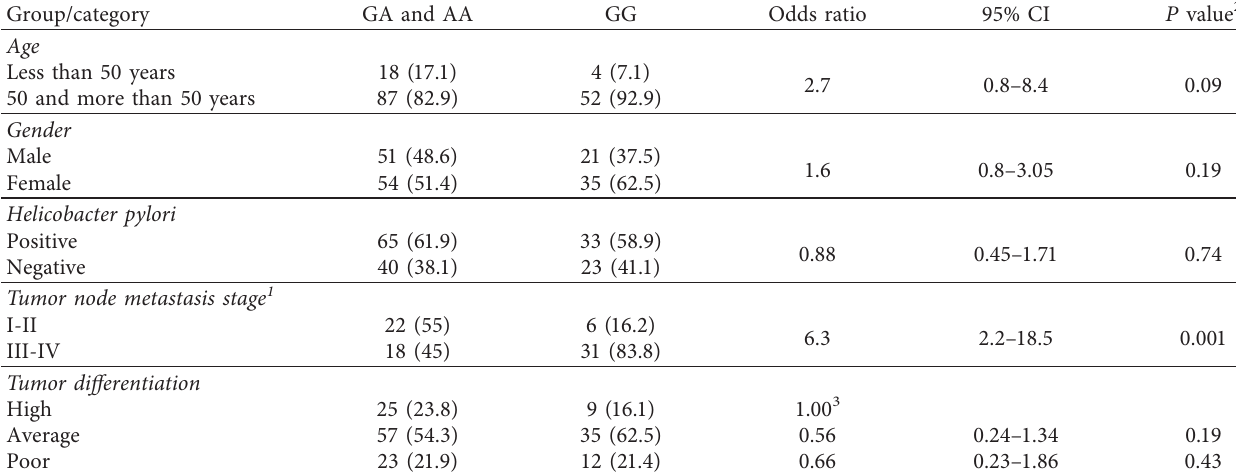
Table 2: Association between G-197A polymorphism and gastric cancer development n